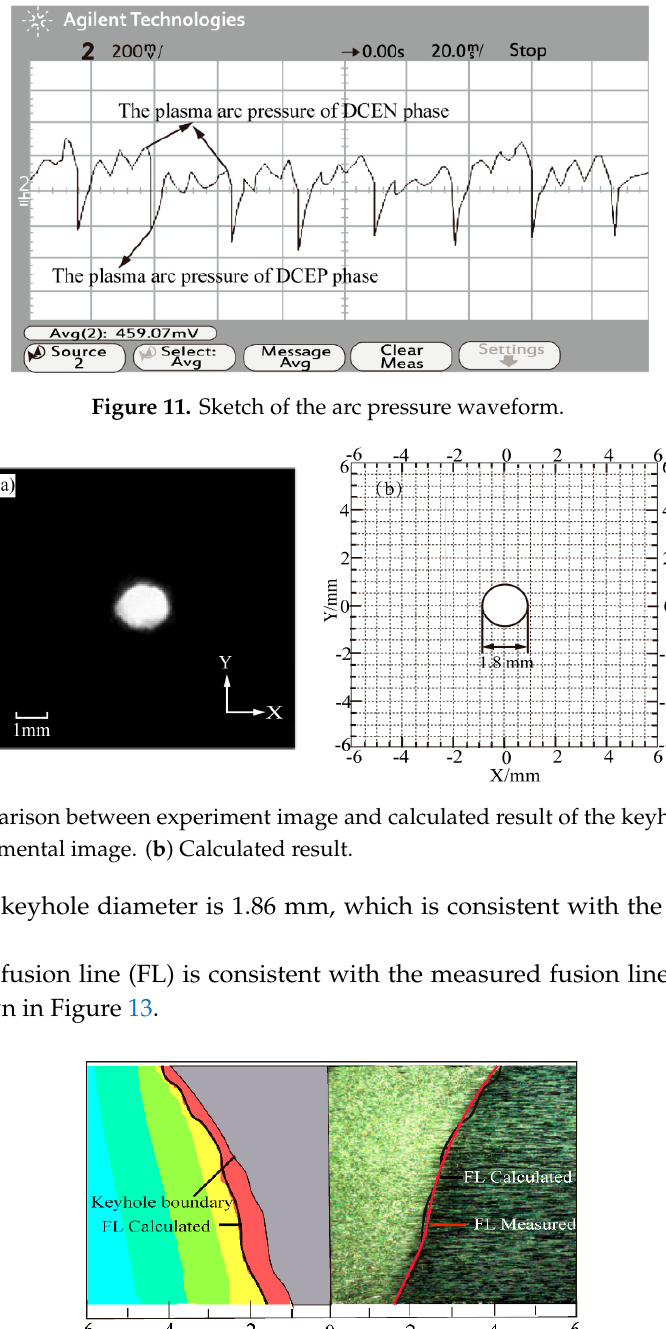
Table 5. The comparison of keyhole perforation time, the front and back dimensions of the weld pool and the back dimensions of the keyhole.